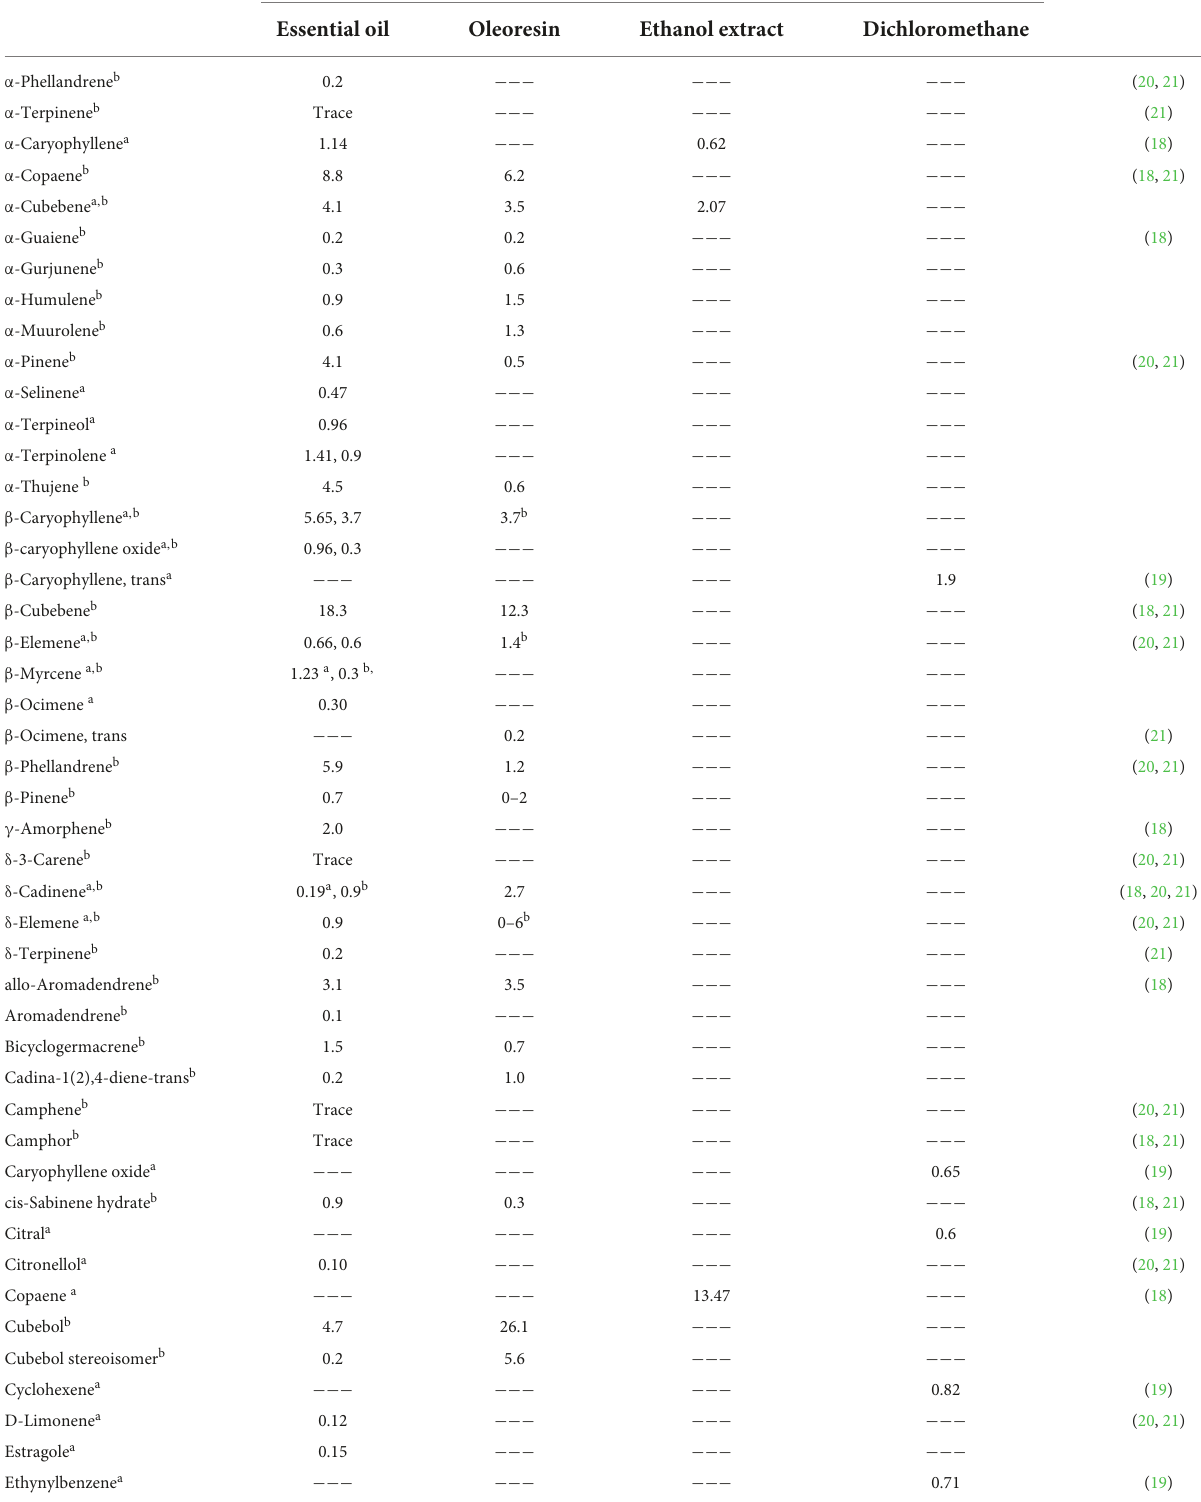
TABLE 3 Identified compounds from essential oil, oleoresin, ethanol and dichloromethane extracts of P. cubeba